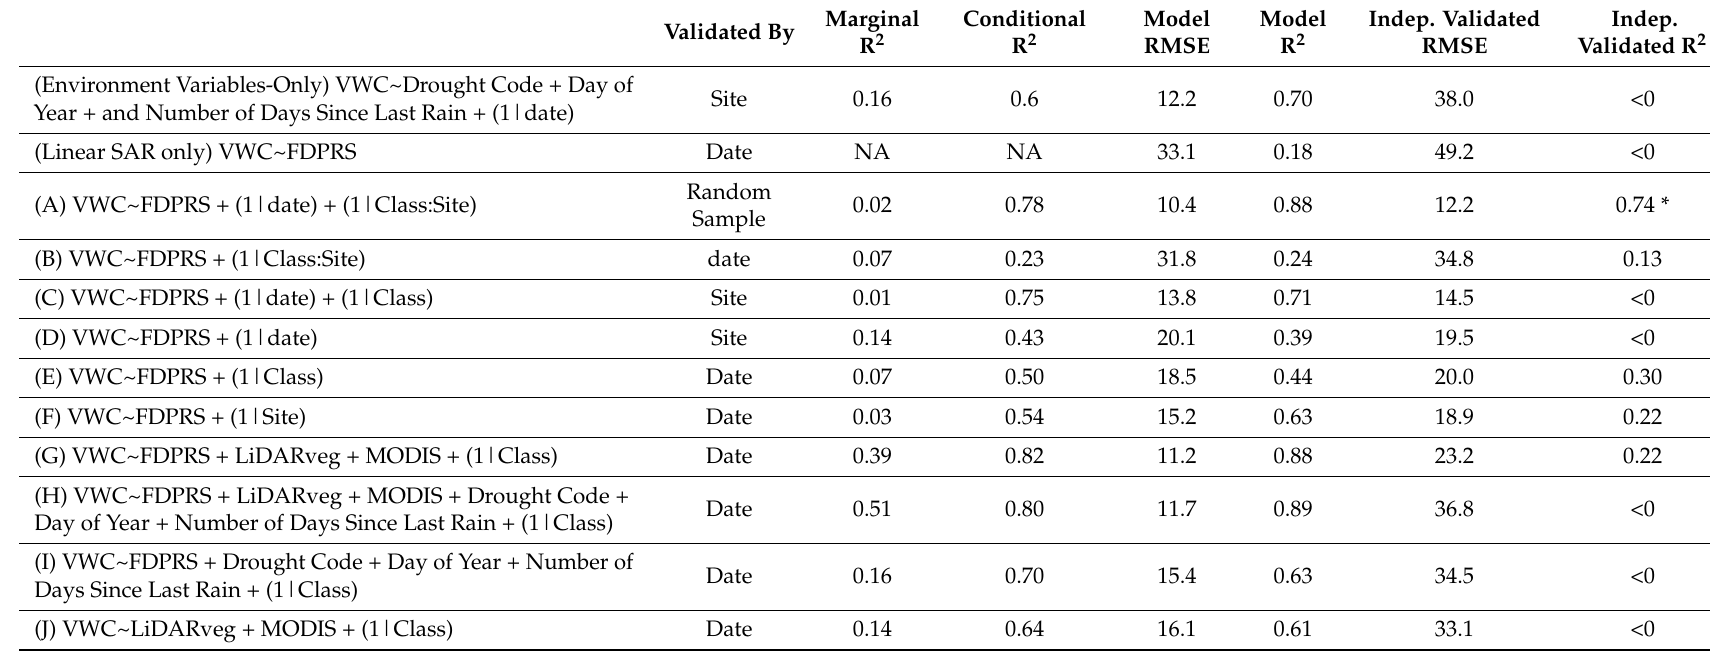
Table 2. Model results including the method of validation, R 2 (marginal, conditional, model, independently validated) and RMSE (model and independently validated). Model A (Random Sample) was run 10 times with a bootstrapped random sample of 50 data points to provide a cross validation and is not a truly independent validation*. Each independent validation was completed by leaving out one site/date for each model run. Validated root mean square error (RMSE) and R 2 are based on the average of validation of all withheld dates/sites. Environment variables-only model represents a model with no remotely sensed data (landscape-level covariates). Marginal R 2 represents the fixed effects component of the model and conditional R 2 represents both fixed and random, calculated using piecewiseSEM [45]. A linear (non-mixed effects) model using only SAR as a predictor was run for